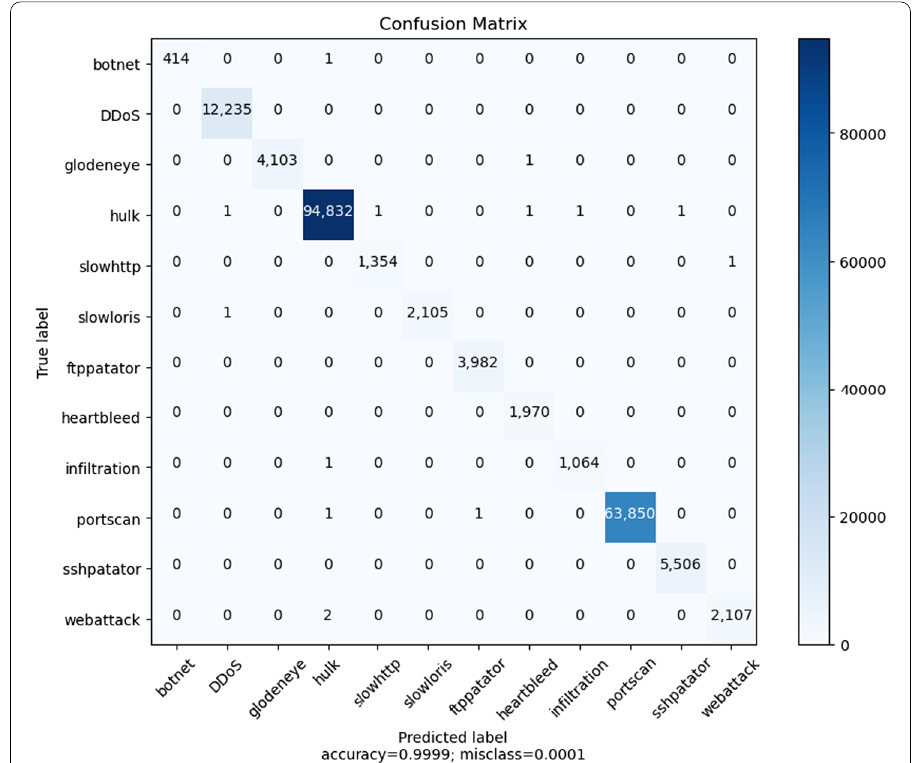
Fig. 9 Heat map of prediction results of MFVT model combined with CPR algorithm